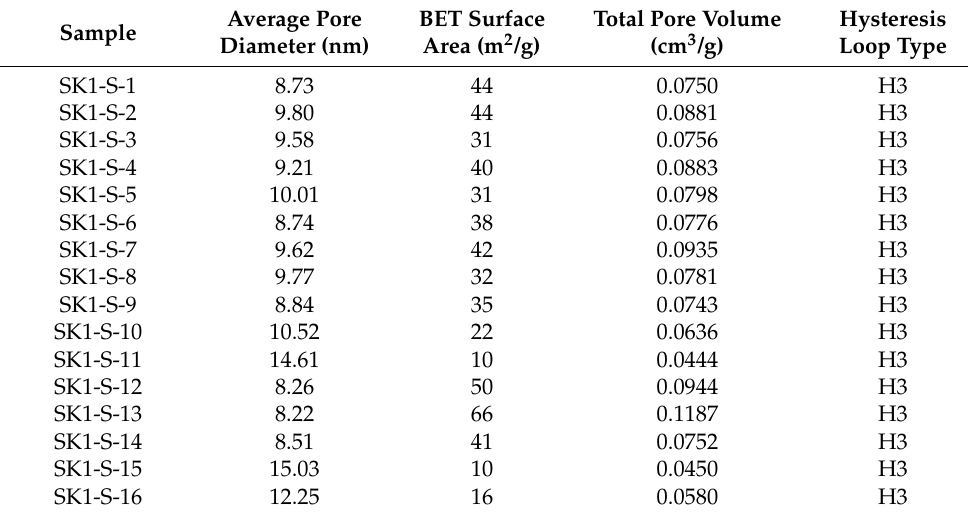
Table 3. Pore parameters of K 2 n 1+2 by low-pressure N 2